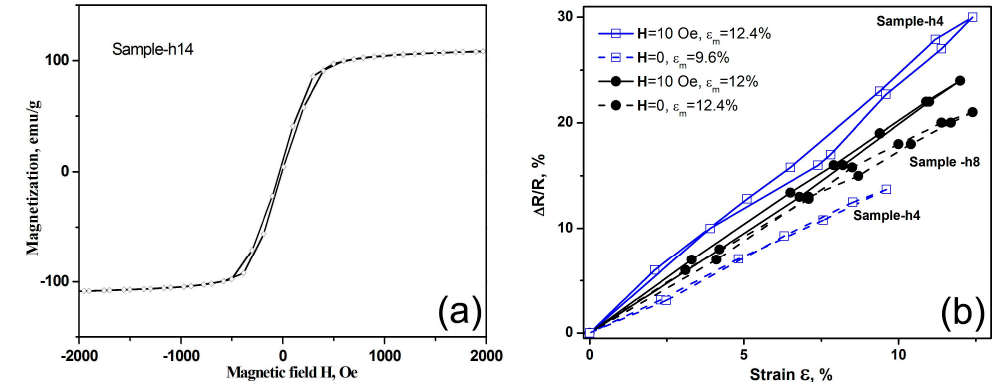
Figure 6. ( a ) Magnetic hysteresis loop of the GA/Co-Fe-P sample; ( b ) The relative changes of resistances of GA/Co-Fe-P samples under compressive strains in a loading (from 0 to ε m ) and un-loading (after ε m to 0) cycle, with and without an applied magnetic field H. ε m denotes the maximum applied strain.